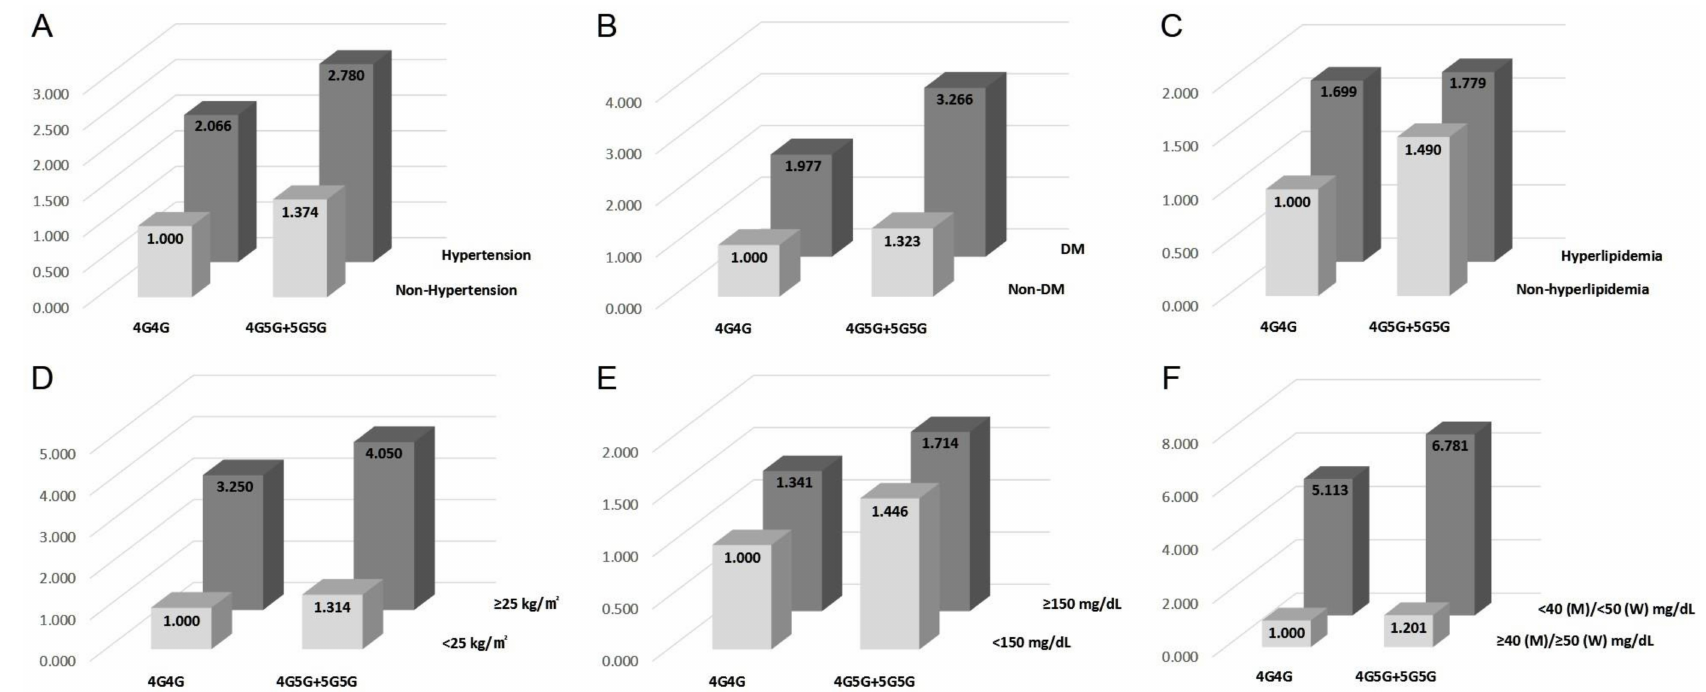
Figure 1. Synergistic e ff ect of PAI-1 − 675 4G > 5G polymorphism with metabolic syndrome-related clinical parameters. ( A – F ) panels show AOR of PAI-1 − 675 4G > 5G with metabolic syndrome-related clinical parameters including hypertension ( A ), diabetes mellitus ( B ), hyperlipidemia ( C ), body mass index ( D ), triglyceride levels ( E ), and high-density lipoprotein cholesterol ( F ),